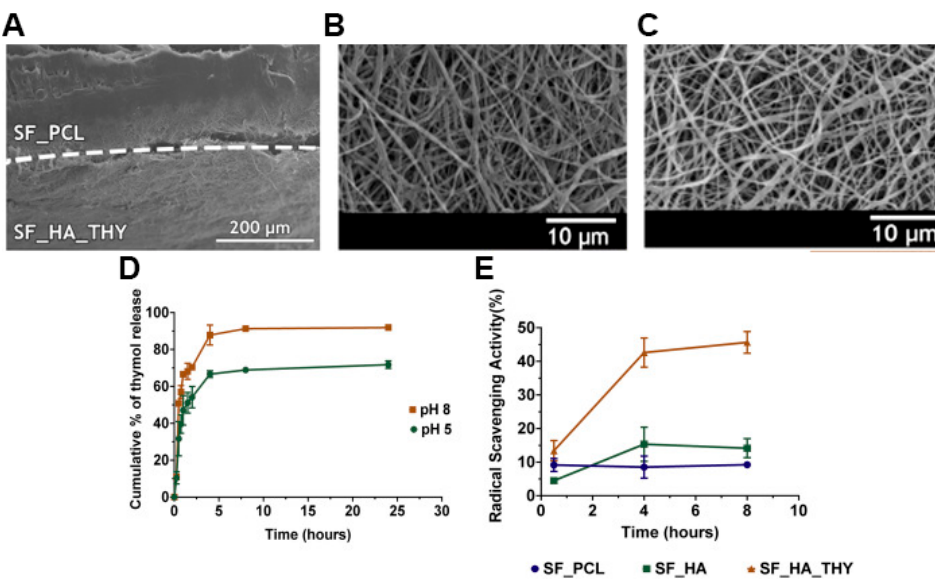
Figure 5. SEM images of ( A ) produced asymmetric membrane cross-section (top layer: SF_PCL; bottom layer: SF_HA_THY); ( B ) SF_PCL after the crosslinking process; ( C ) SF_HA_THY after the crosslinking process; ( D ) evaluation of the THY In Vitro release profile; ( E ) evaluation of the antioxidant activity of the SF-PCL membrane (top layer), SF-HA membrane (bottom layer) with or without THY. Reprinted with permission from [20], Elsevier, 2019.